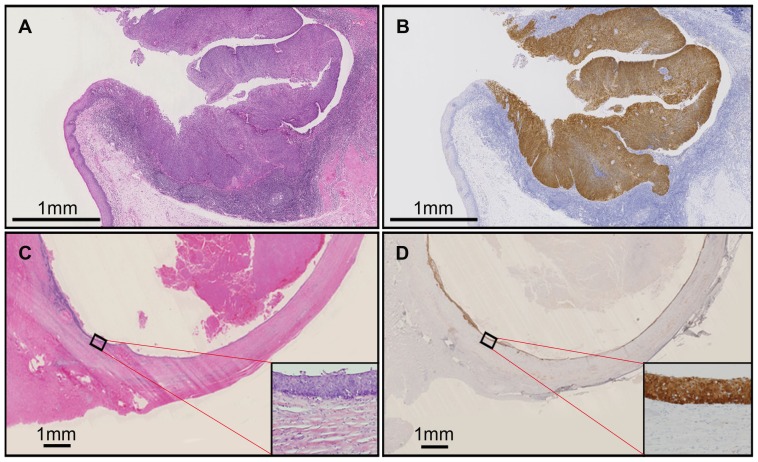
Hematoxylin and eosin staining (A, C) and p16 immunohistochemistry (B, D) of occult tonsillar cancer (A, B) and its corresponding cystic node metastasis (C, D).The scale bar corresponds to 1 mm.